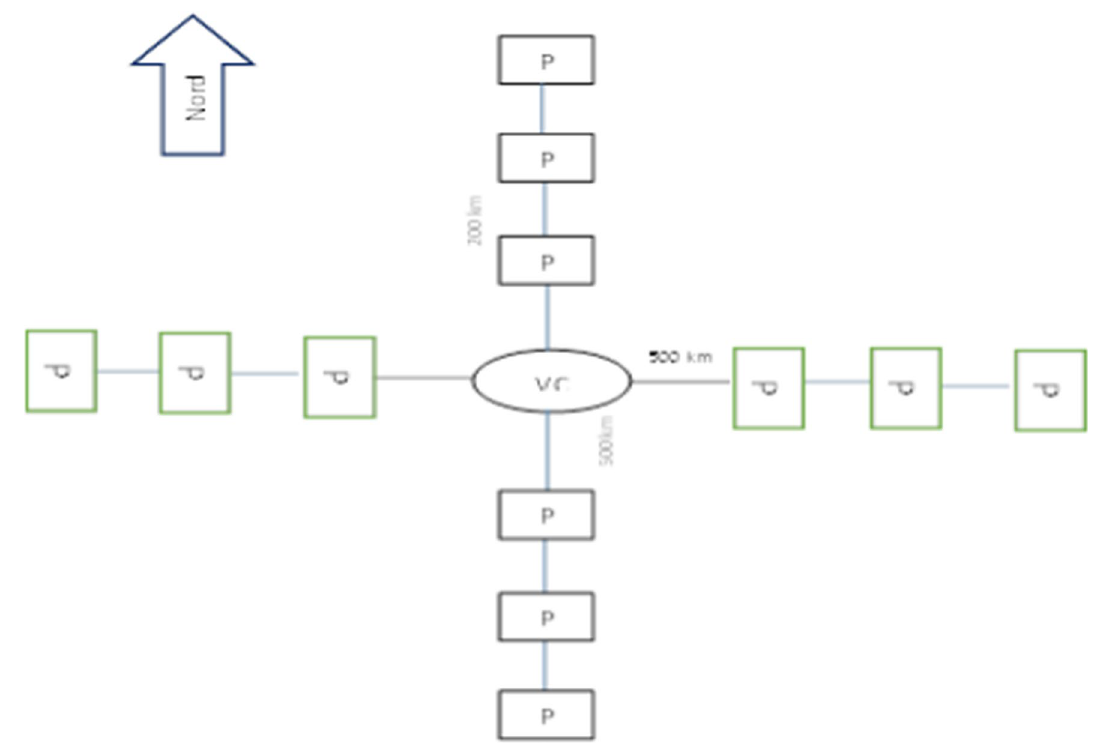
Fig. 1 Woody vegetation inventory frame. VC Village central, P